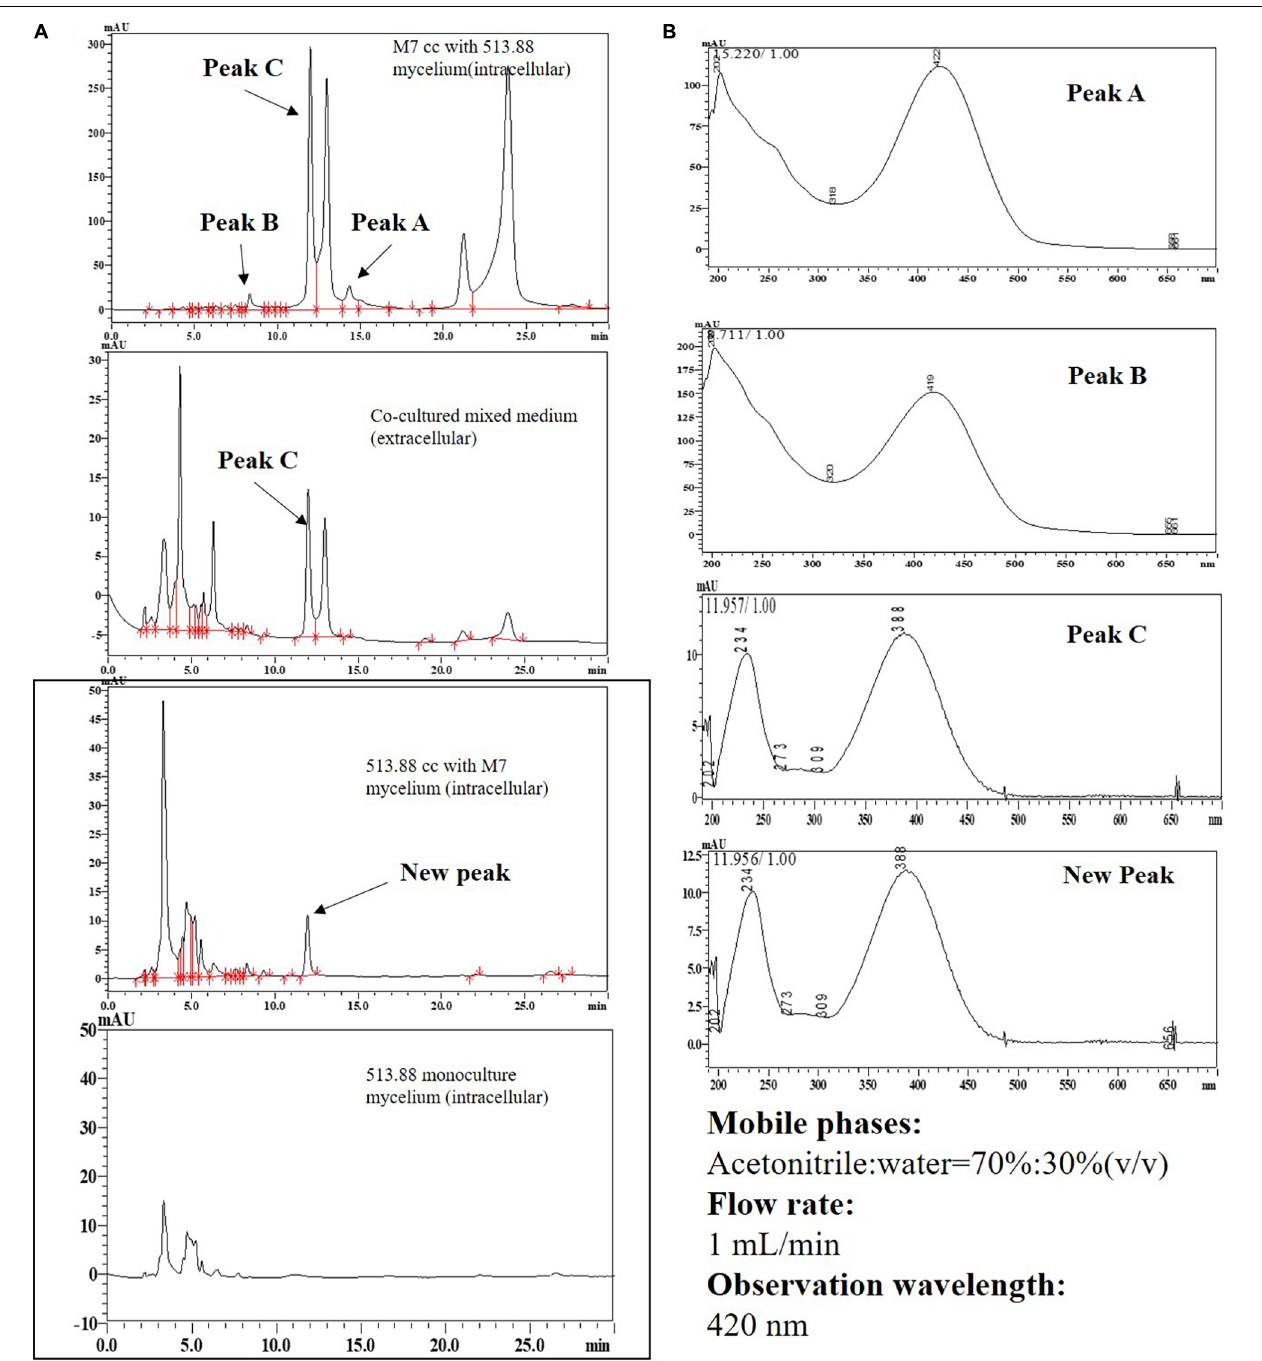
FIGURE 9 | High performance liquid chromatography results of substance A and B in different cocultivation samples: (A) HPLC results; (B) UV-spectrum results. Abbreviations: CC-cocultured; M7- Monascus ruber M7; 513.88- A. niger CBS 513.88.